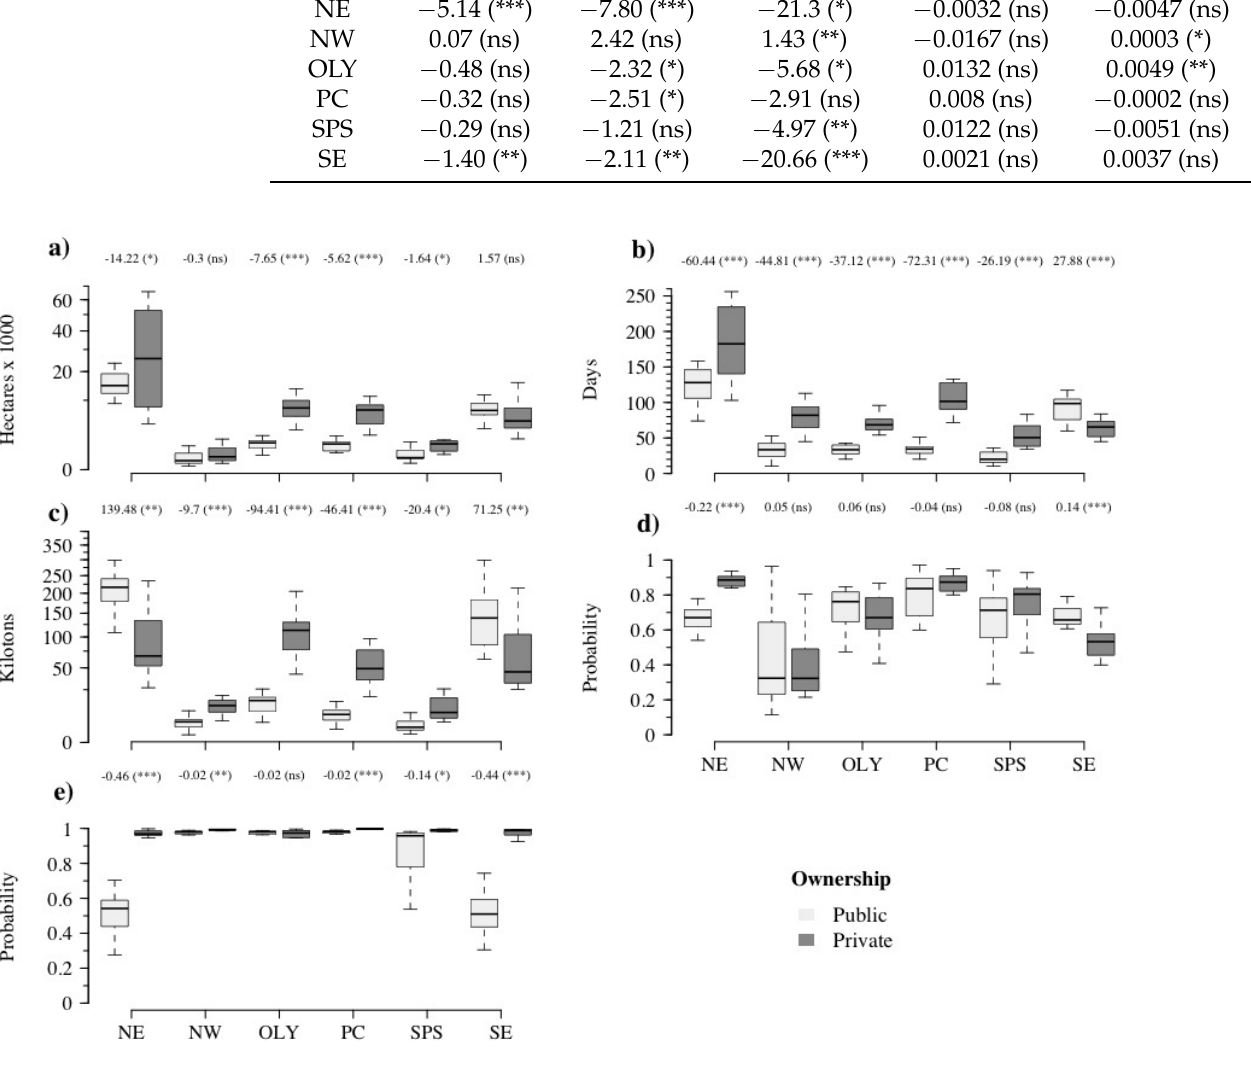
Figure 3. Boxplot comparison of five annual prescribed fire parameters between public and private lands within each DNR administrative region (Northeast (NE), Northwest (NW), Olympic (OLY), Pacific Coast (PC), South Puget Sound (SPS), and Southeast (SE)). Each panel describes the conditional distributions of a prescribed fire parameter: burned area ( a ), burn days ( b ), burned biomass ( c ), approval probability ( d ), and pile probability ( e ). p -values greater than 0.03 are interpreted as not significant (ns), p -values less than 0.03 are interpreted as significant (*), p -values less than 0.0075 are interpreted as strongly significant (**), and p -values less than 0.0005 are interpreted as very strongly significant (***). See Section 2.2.1 for